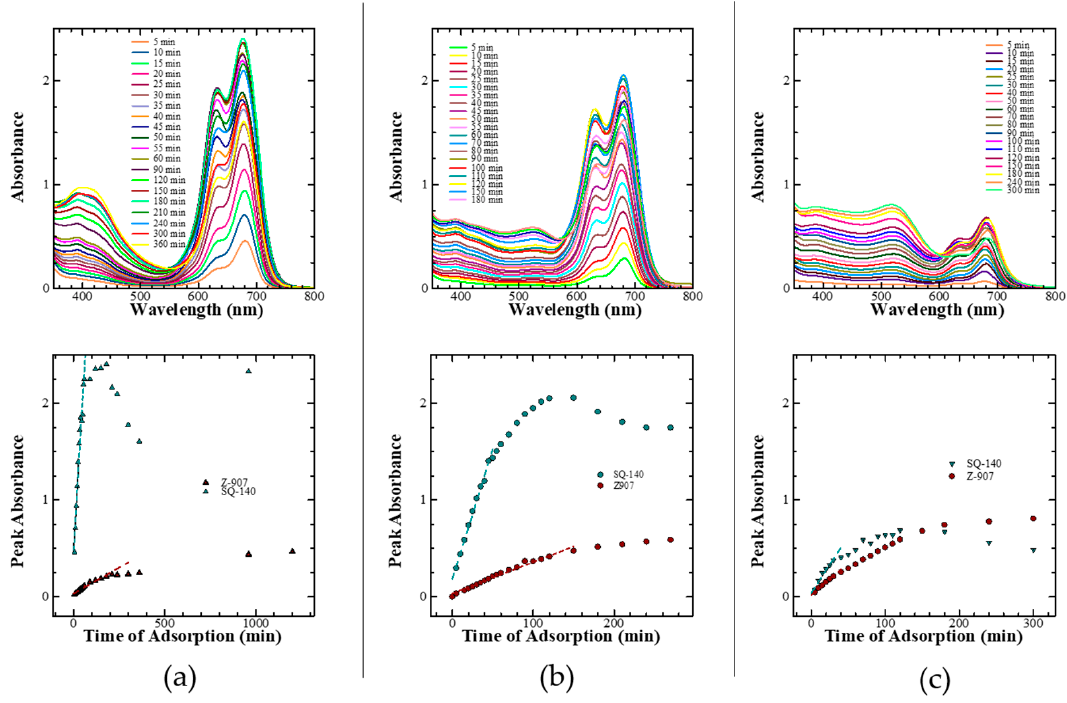
Figure 6. Change in the absorption spectra (top) and peak absorbance corresponding to Z-907 and SQ-140 as a function of time (bottom) for the dye adsorption on mesoporous TiO 2 from the dye cocktails of two sensitizing dyes taken in different molar ratios ( a ) 1:9, ( b ) 1:1, and ( c ) 9:1. 2.4.3. BF-DSSC Utilizing Dye Cocktails Z-907 and SQ-140 Dyes and 1 h of Dye